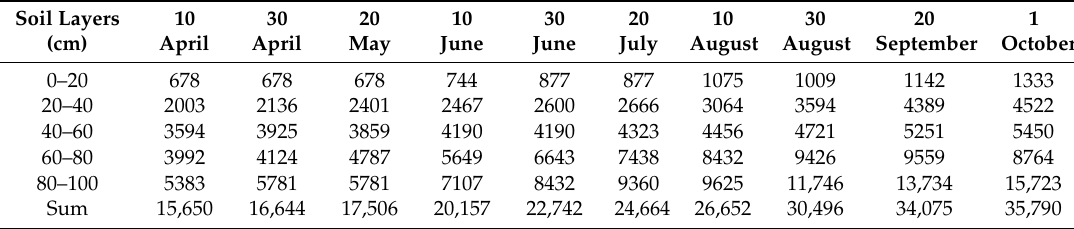
Table 9. Salt-storage changes at Site A1 in di ff erent periods (kg hm − 2 ).